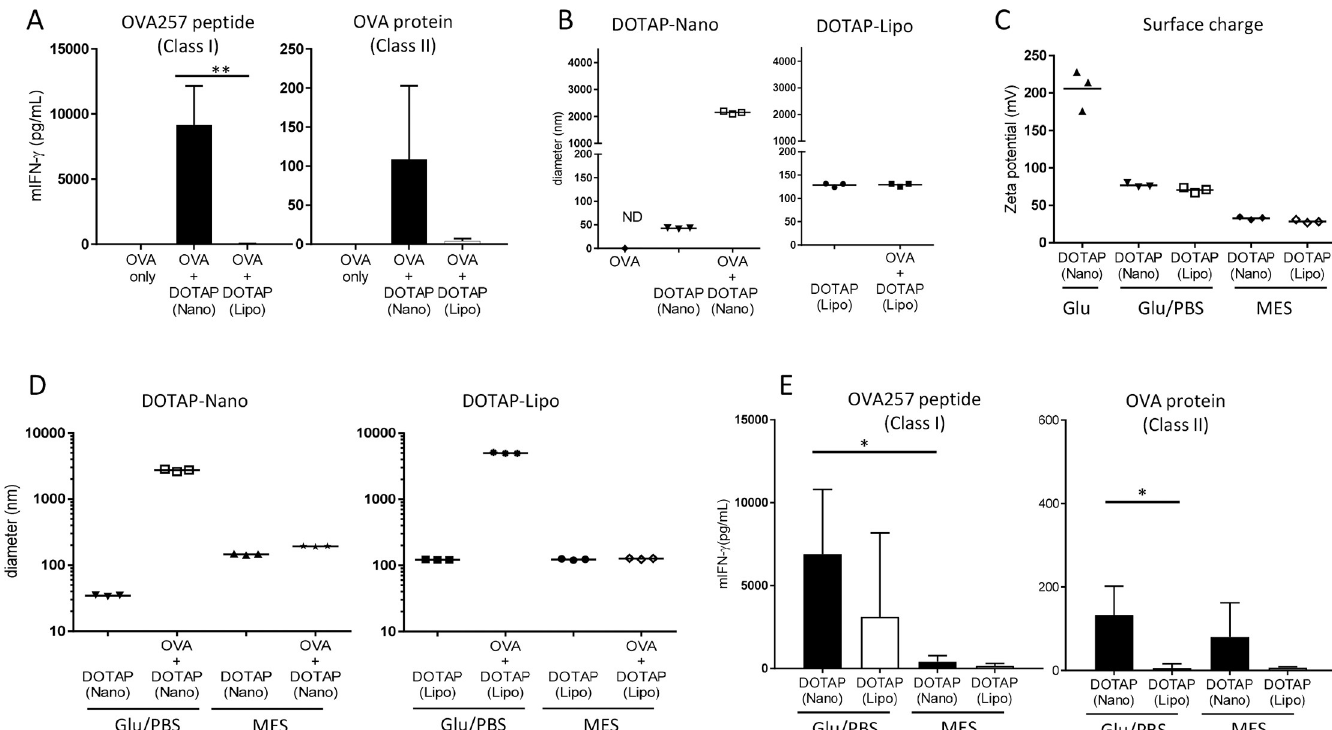
Fig 1. Particle preparations of DOTAP influenced the adjuvanticity. (A) C57BL/6J mice were immunized with OVA (10 μ g) and DOTAP (100 μ g) at the tail base. After seven days, splenocytes were collected and stimulated with OVA257-264 peptide, which induced an MHC class I–restricted CD8 + T-cell response, or with OVA protein, which induced an MHC class II–restricted CD4 + T-cell response. Twenty-four hours later, mouse IFN-gamma in the culture supernatant was determined by ELISA. The bar graph indicates the mean ± SD of three mice per group.(B) The sizes of OVA only, lipid particle only, and lipid mixed with OVA were determined by the dynamic light scattering (DLS) method. An increase in particle size indicates that the lipid particle interacts with OVA protein. Each dot indicates one measurement. (C) The zeta potential of lipid particles in the indicated buffer conditions was measured by a zetasizer. Each dot indicates one measurement. (D) The sizes of lipid particles and lipids mixed with OVA were measured by DLS under the indicated buffer conditions. An increase in particle size indicates that the lipid particle interacts with OVA protein. Each dot indicates one measurement. (E) C57BL/6J mice were immunized at the tail base with OVA mixed with either DOTAP-Nano or DOTAP-Lipo under the indicated buffer conditions. After seven days, splenocytes were stimulated with OVA257-264 peptide, which induced an MHC class I–restricted CD8 + T-cell response, and with OVA protein, which induced an MHC class II–restricted CD4 + T-cell response. Twenty-four hours later, mouse IFN-gamma in the culture supernatant was determined by ELISA. The bar graph indicates the mean ± SD of three mice per